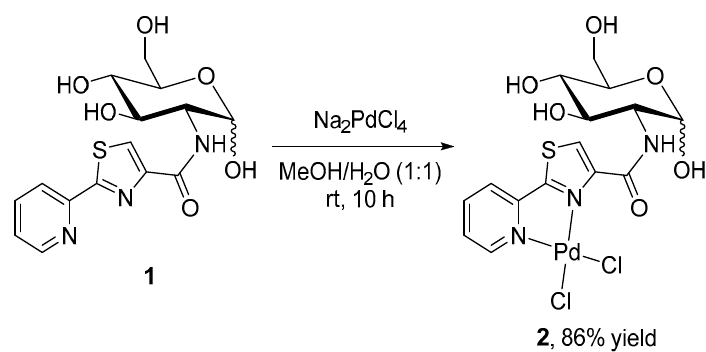
Scheme 1. Synthesis of the glycoconjugated palladium(II) complex 2 .